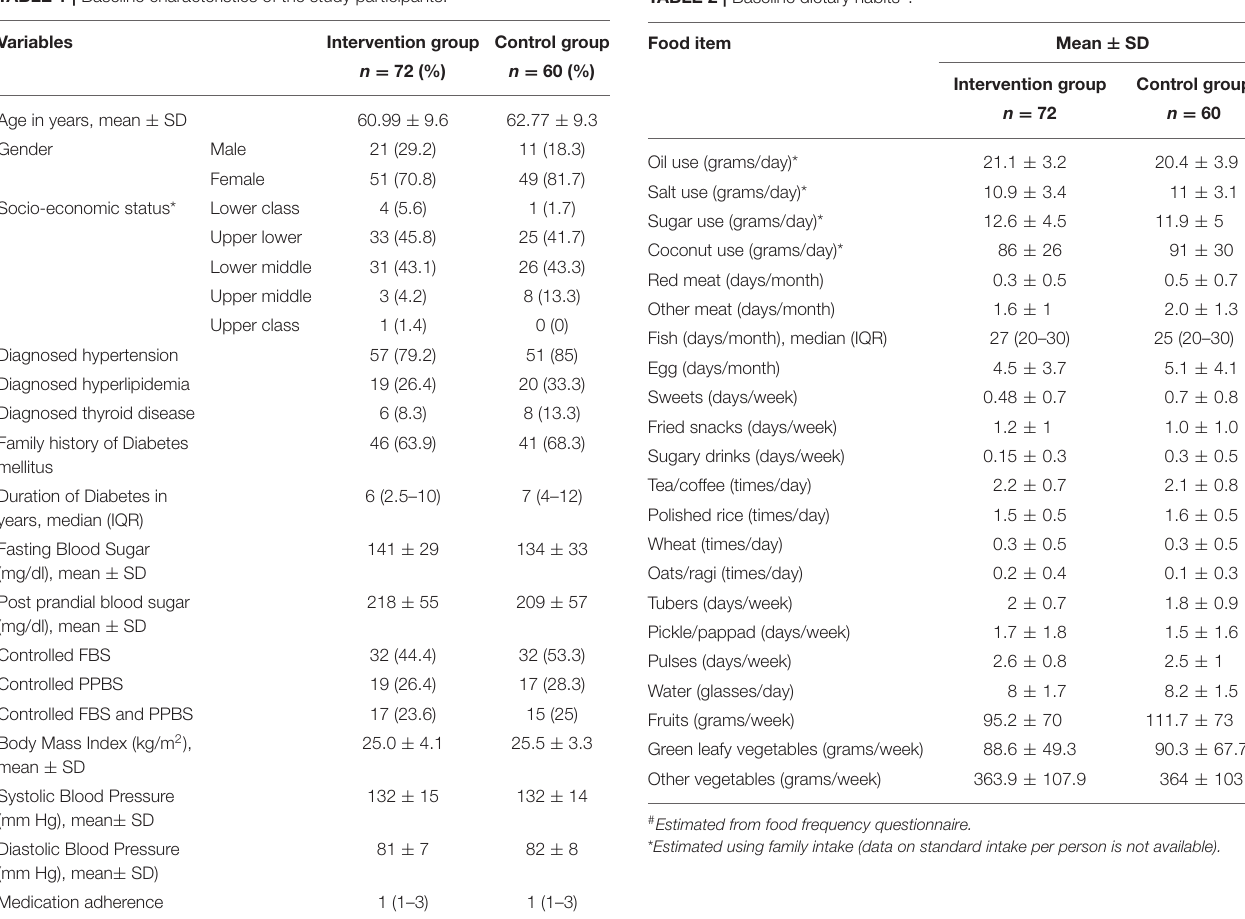
TABLE 1 | Baseline characteristics of the study participants. TABLE 2 | Baseline dietary habits # .